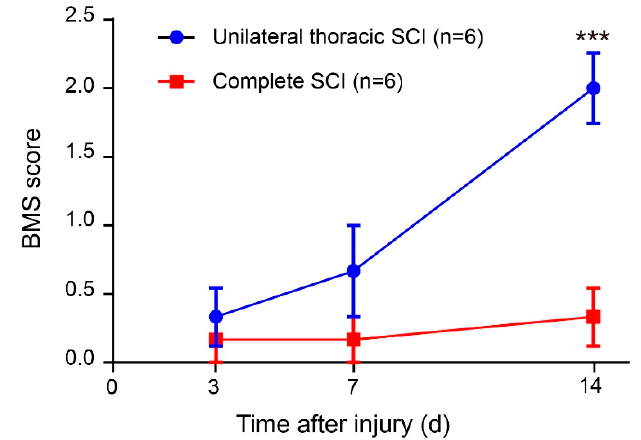
Figure 7. BMS (Basso Mouse Scale) score. Two-way repeated-measures ANOVA followed by post hoc Bonferroni correction. *** p < 0.001. Error bars represent SEM.